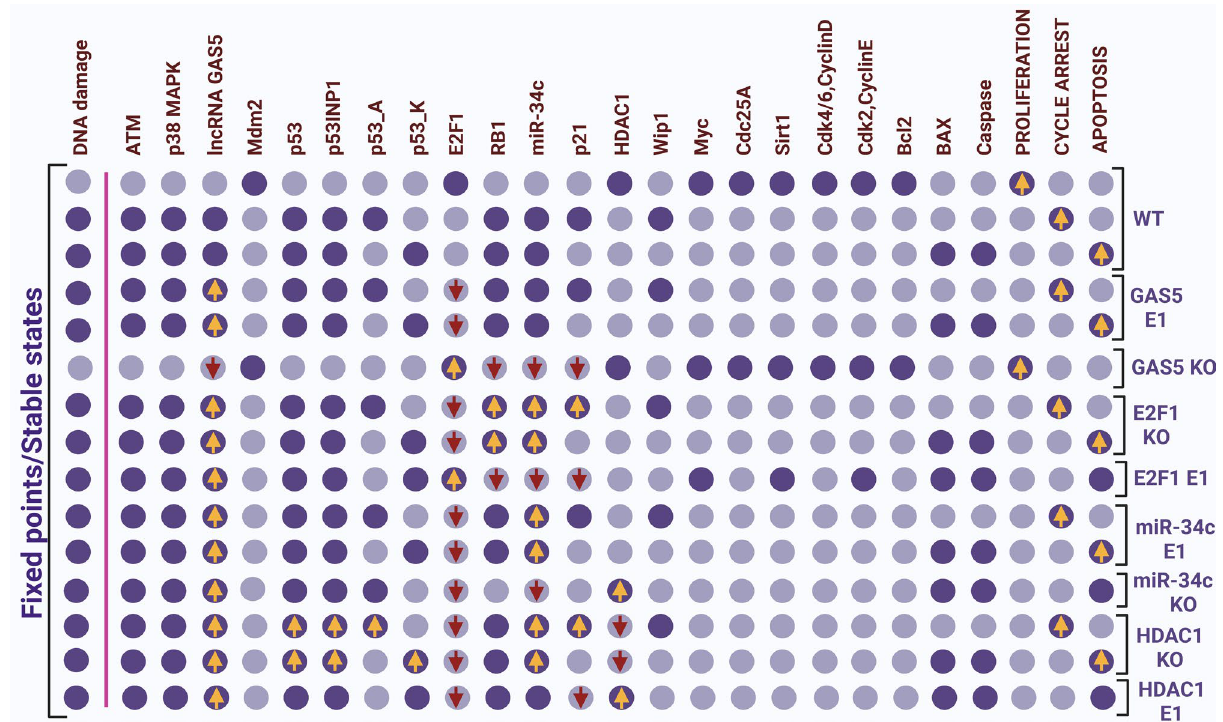
Figure 2. Model fixed points for WT case and perturbations. The fixed points identified for distinct scenarios: WT, GAS5 E1, GAS5 KO, E2F1 KO, E2F1 E1, miR-34c E1, miR-34c KO, HDAC1 KO, HDAC1 E1, and p53 KO. Ectopic expression (E1) represents gain-of-function (GoF) while knockdown (KO) represents loss-of- function (LoF) of the respective network element. The leftmost column shows the level of DNA damage with other molecules separated by a pink line. At the same time, the rightmost columns show the model outputs: proliferation, cell cycle arrest, and apoptosis. Each line represents a fixed point or steady state corresponding to the input. Light purple cells indicate a zero value (inactivation), while dark purple cells indicate activation (value 1). The first three fixed points belong to the wild-type case. The remaining fixed points explain how GAS5 regulates the miR-34c expression, and at the end, three fixed points linked to the HDAC1/p21 pathway represent activation of p21 via knockdown of HDAC1 by miR-34c. The GoF of GAS5 accelerates miR-34c expression that triggers cell cycle arrest and apoptosis, whereas knockdown (KO) of GAS5 inhibits miR-34c expression but induces E2F1 that, triggers proliferation. Knockdown (KO) of E2F1 increases miR-34c expression that induces cycle arrest and apoptosis, whereas its gain of function (GoF) inhibits miR-34c expression. Overexpression of miR-34c induces cell cycle arrest and apoptosis, whereas knockdown (KO) triggers apoptosis. Next, the knockdown (KO) of HDAC1 enhanced p21 expression, which means induction of cell cycle arrest, and apoptosis. In comparison, its gain-of-function (GoF) inhibits p21 expression and induces apoptosis. Yellow arrows represent upregulation, while the red arrows facing down represent downregulation,